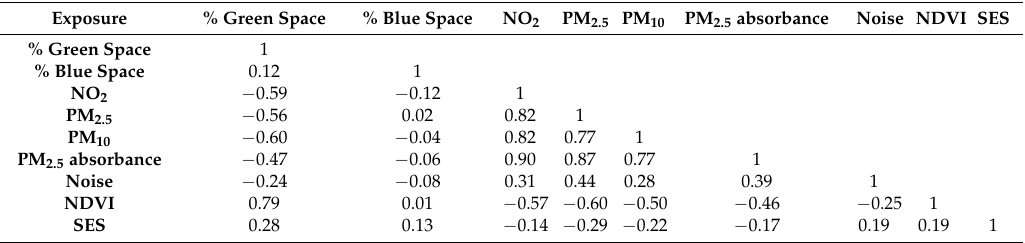
Table 3. Correlations (Pearson) between different pollutants (residence during first year) and covariates in Barcelona. Particulate matter with aerodynamic diameter less than 2.5 µ m (PM 2.5 ), between 2.5 µ m and 10 µ m (PM 2.5–10 , i.e., coarse particulate matter), less than 10 µ m (PM 10 ) and PM 2.5 light absorption (PM 2.5